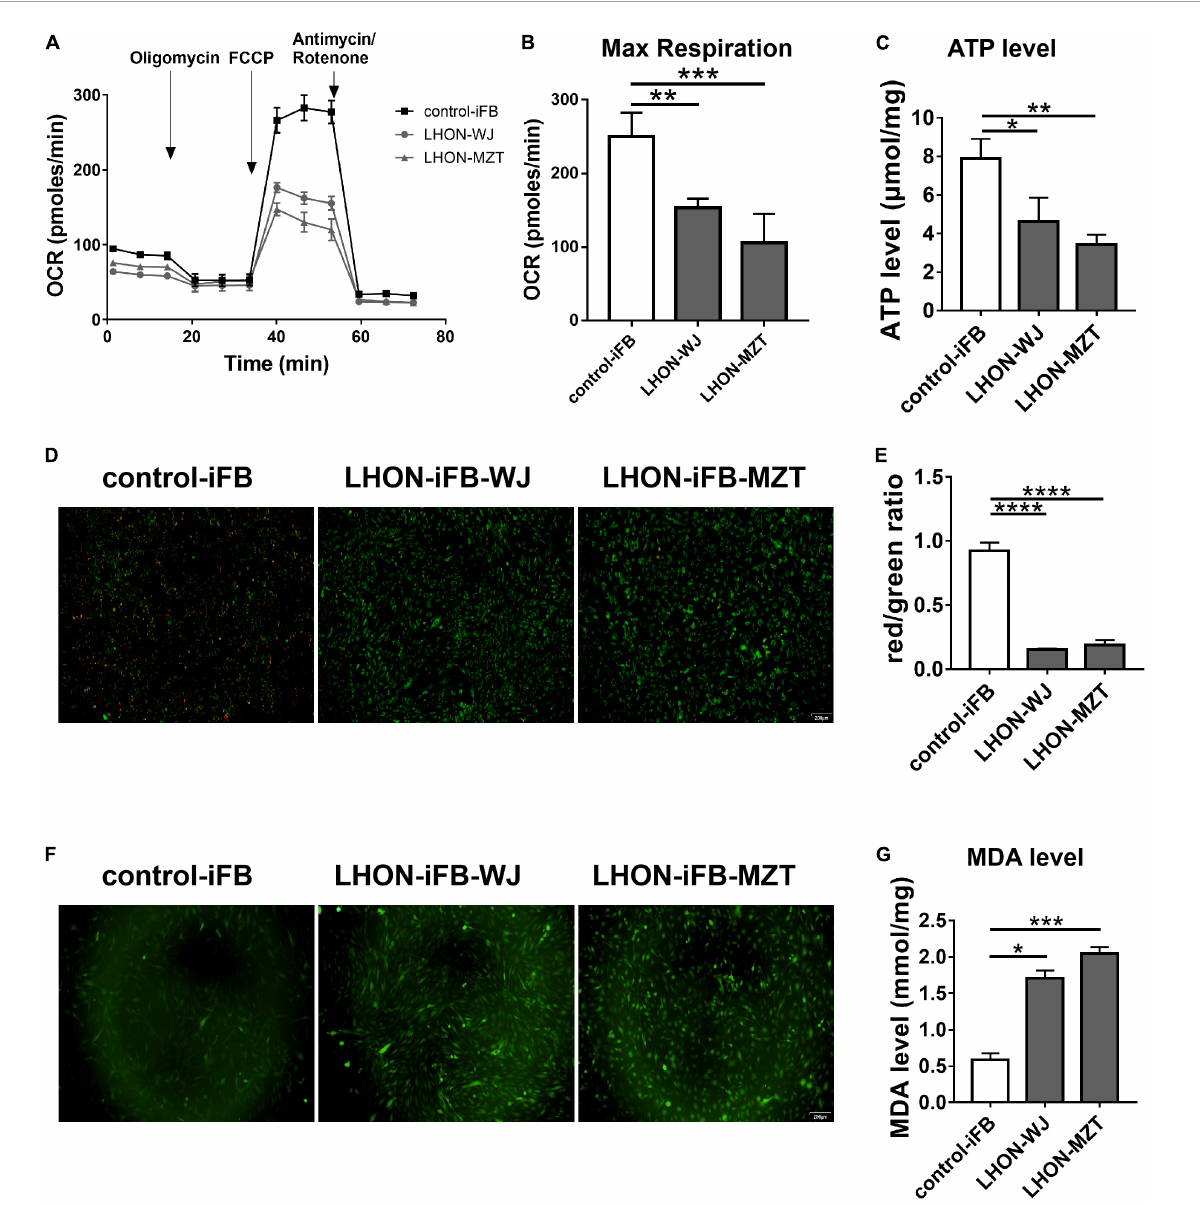
FIGURE1 LHON-iFBs presented mitochondrial dysfunction and oxidative stress. (A,B) OCR, (C) ATP level, (D,E) mitochondrial membrane potential, and (F) ROS level in LHON-iFBs and control-iFB were measured immediately after samples were prepared from each group. (G) The level of MDA in fibroblasts were detected, respectively. The results (mean ± SD) were statistically significant (* p < 0.05, ** p < 0.01, *** p < 0.001, **** p < 0.0001, n = 3–5) by using one-way ANOVA with Bonferroni correction, and the assays were performed three times.